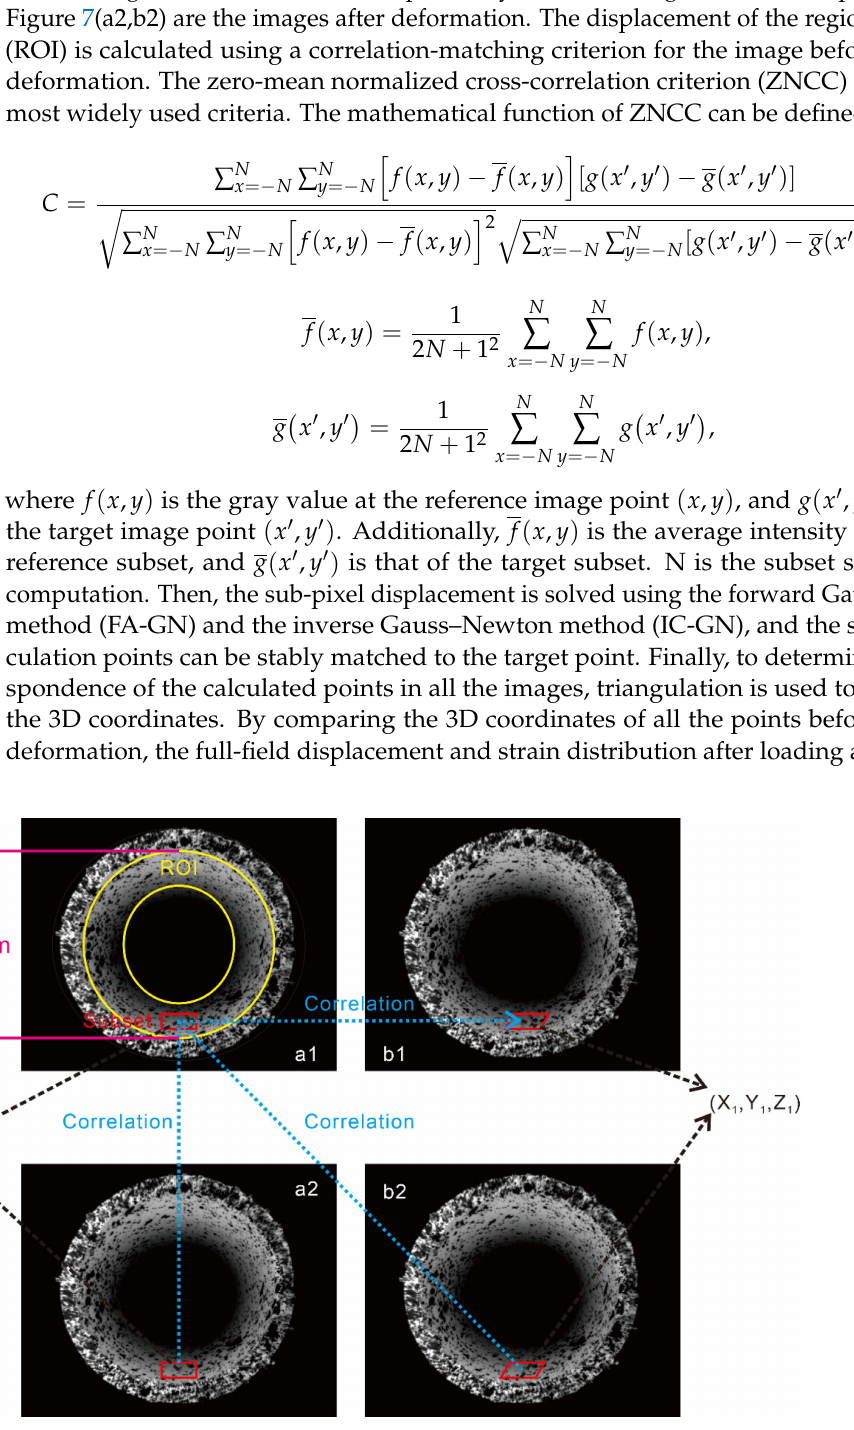
Figure 7. Principle of stereo matching of 3D-DIC images. ( a1 , a2 ) left image before and after deforma- tion; ( b1 , b2 ) right image before and after